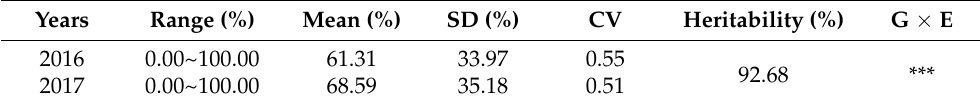
Table 1. Descriptive statistics of germination rate at three days after imbibition in two years.